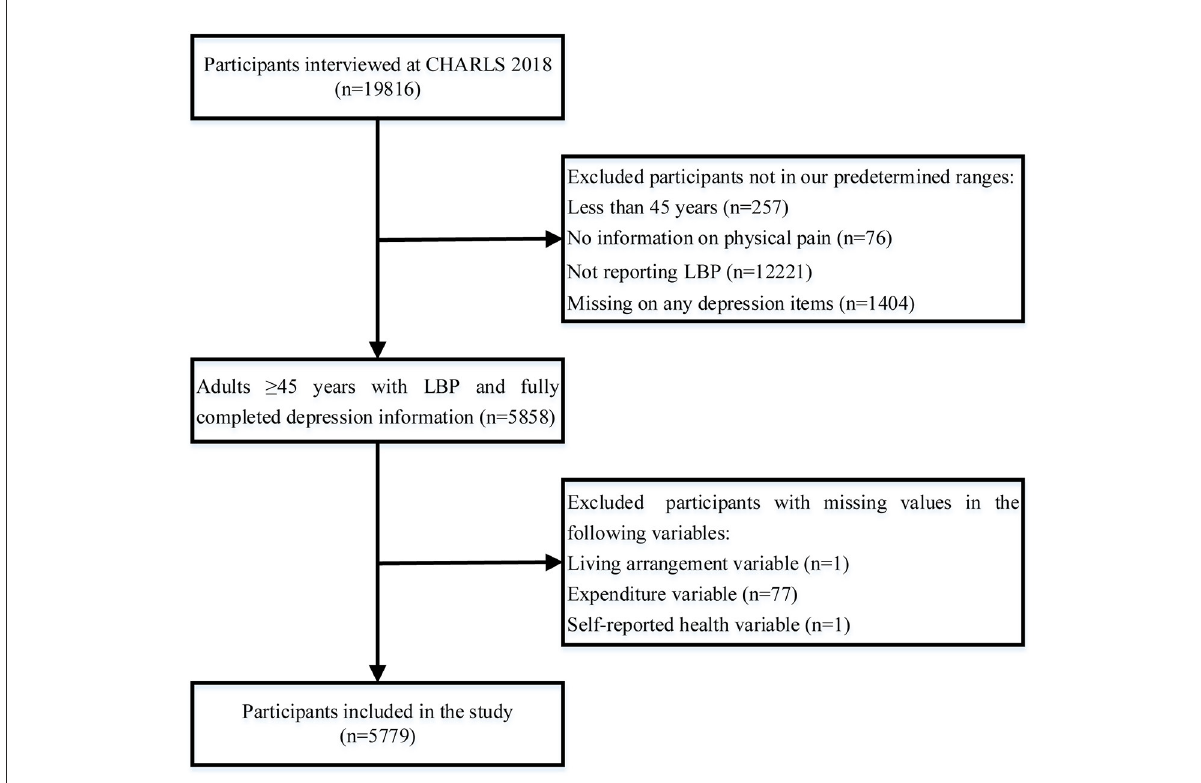
FIGURE1 Flowchart for screening study subjects. CHARLS, China Health and Retirement Longitudinal Study; LBP, Low back